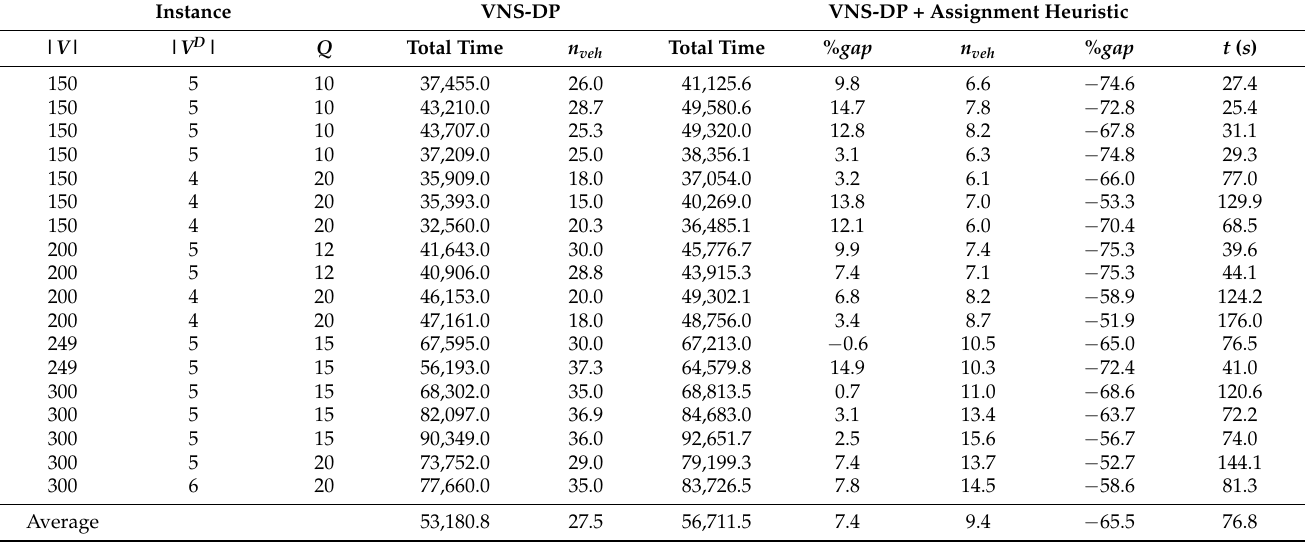
Table 12. Performance of assignment